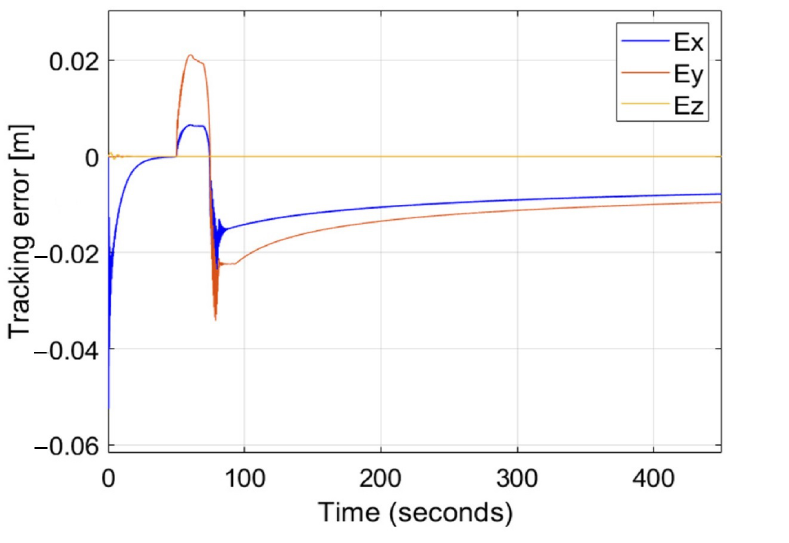
Figure 12. Time plots of position tracking errors for the nonlinear PID controller in the case of simul- taneous longitudinal and lateral wind gusts while gains of the PID’s terms are greater than